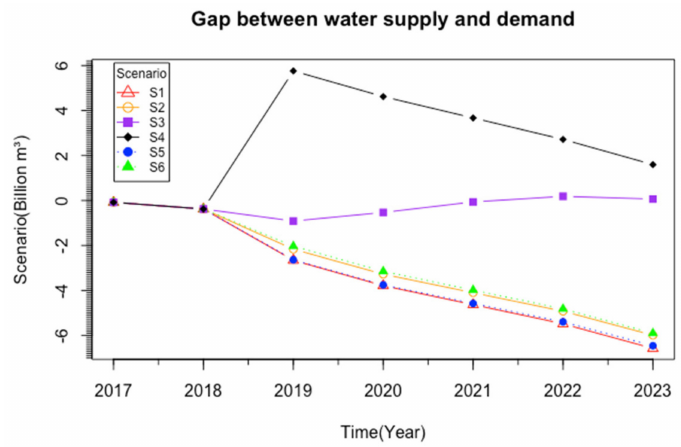
Figure 14. Comparison of the simulation results from scenarios